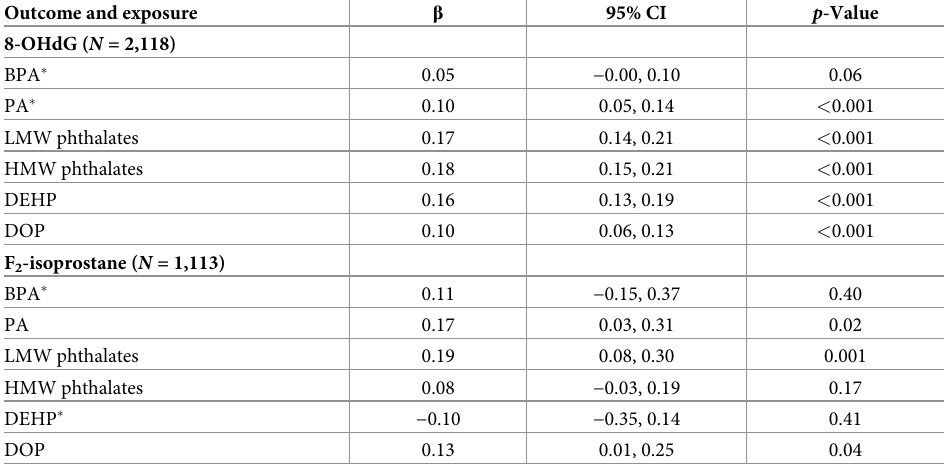
Table 5. Associations between ln-transformed chemical exposures and ln-transformed oxidative stress biomark- ers from linear mixed-effects models. Outcome and exposure β 95% CI p -Value